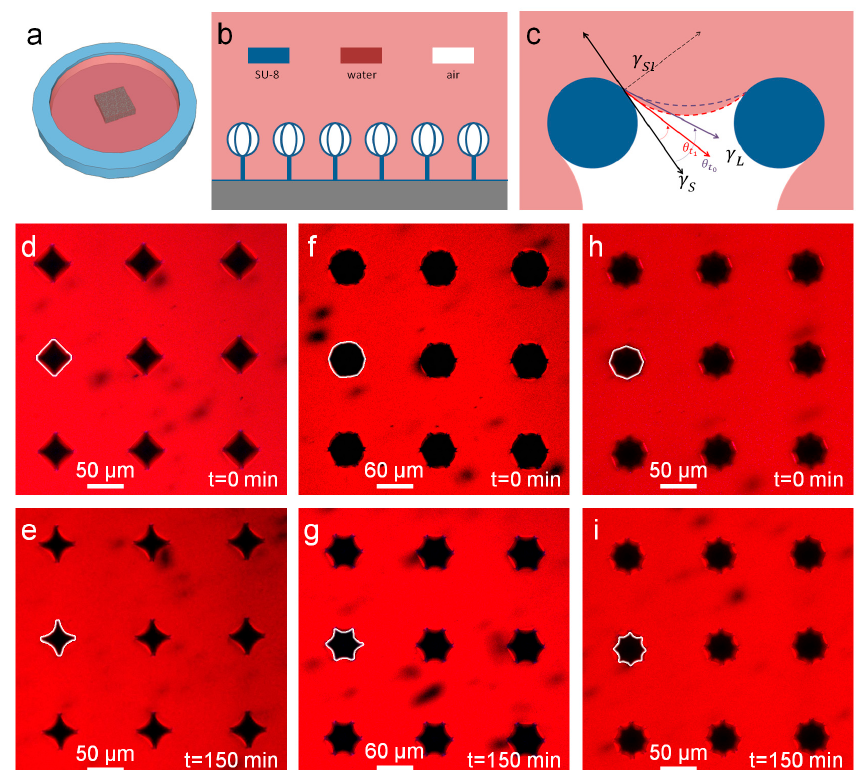
Figure 3. ( a ) Sketch of the sample used for the experimental procedure at the confocal microscope: the array (the square in the center) with the structures is confined by a poly-(dimethylsiloxane) (PDMS) ring (in blue), filled with water marked with tetramethylrhodamine-5-(and-6)-isothiocyanate (5(6)-TRITC) (in red) and then sealed with a thin glass slide on the top (not shown); ( b ) Scheme of the ‘macro’ Wenzel state (the water fills all the room over the hairs and between the stalks) and the ‘micro’ Cassie–Baxter (the water cannot reach the inside of the heads), that are experienced by all the tested samples; ( c ) Scheme (not in scale) of the interaction of water (in red), air (in white) and SU-8 (structural material, in blue), related to Equation (1). The red and violet arrows show the variation of the contact angle θ during time (from θ t0 to θ t1 respectively); ( d ) Example of heads with four filaments (design 10) recorded at the confocal microscope, showing the profile of the air–water interface (in white) at the starting point of the experiment; ( e ) Same sample reported in ( d ) after 150 min, showing the variation of the air–water interface (in white). Similarly, in ( f , g ) examples of heads with six filaments (design 14) and in ( h , i ) of eight filaments (design 12), taken at the starting point of the experiment and after 150 min.